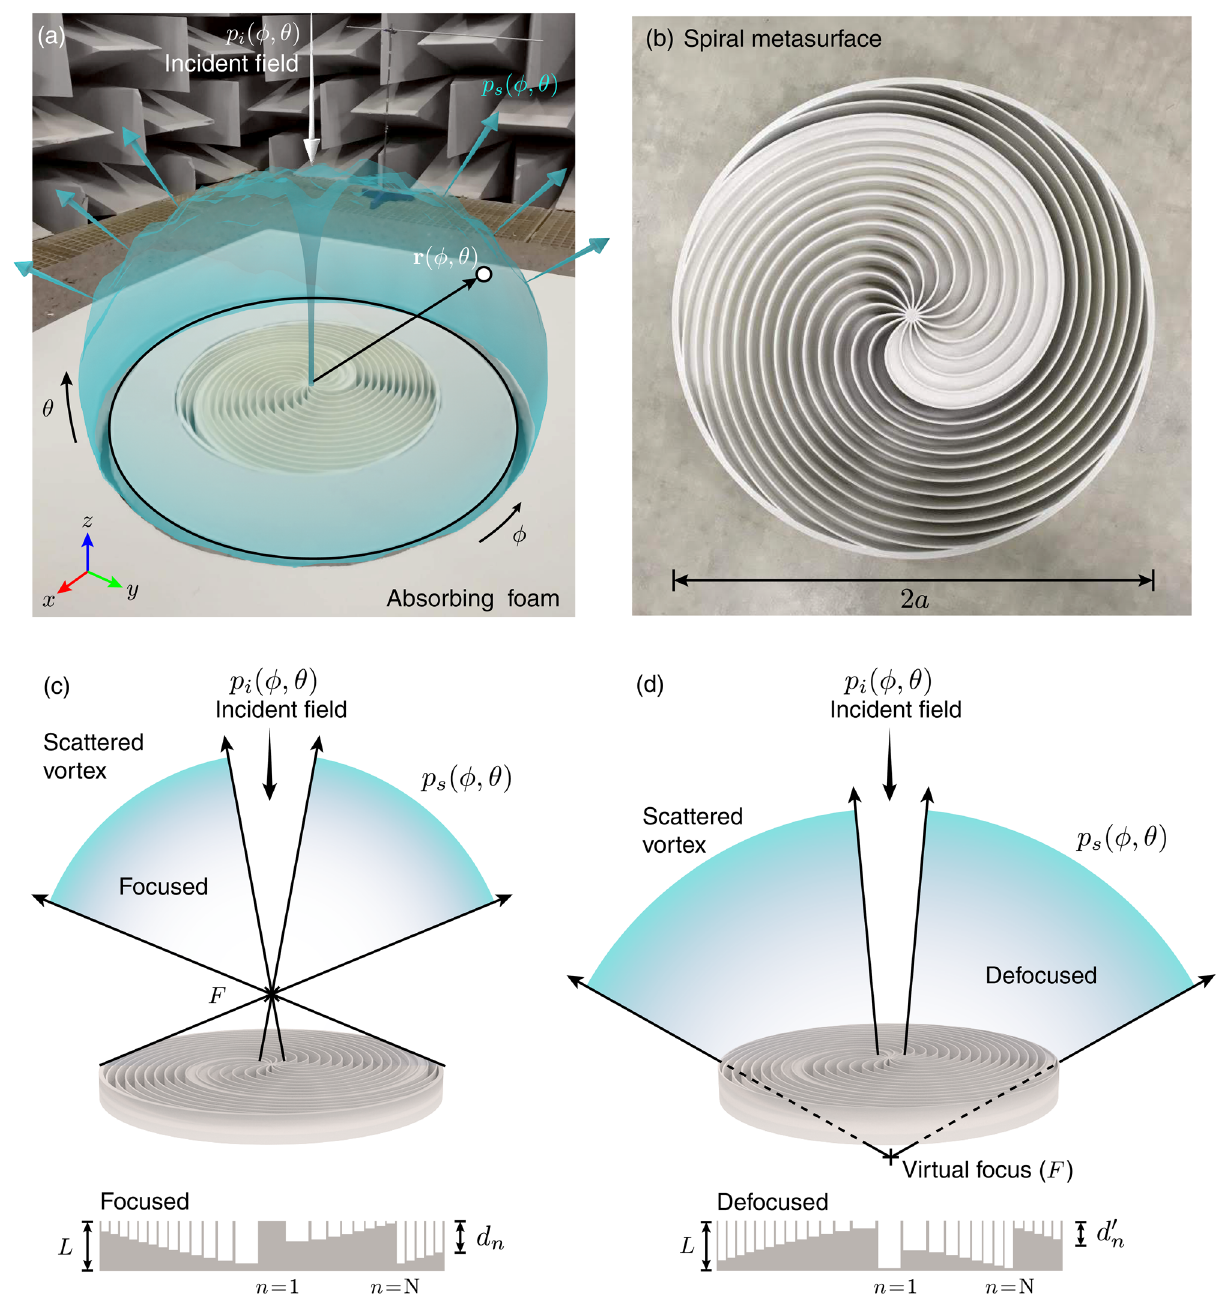
Figure 1. ( a ) Scheme of the proposed spiral-shaped sound diffusing metasurface. ( b ) Geometry of the panel for the focusing configuration. ( c ) Spiral metasurface for the focusing configuration and its geometry. ( d ) Spiral metasurface designed for the defocusing configuration using a virtual image of a vortex and its